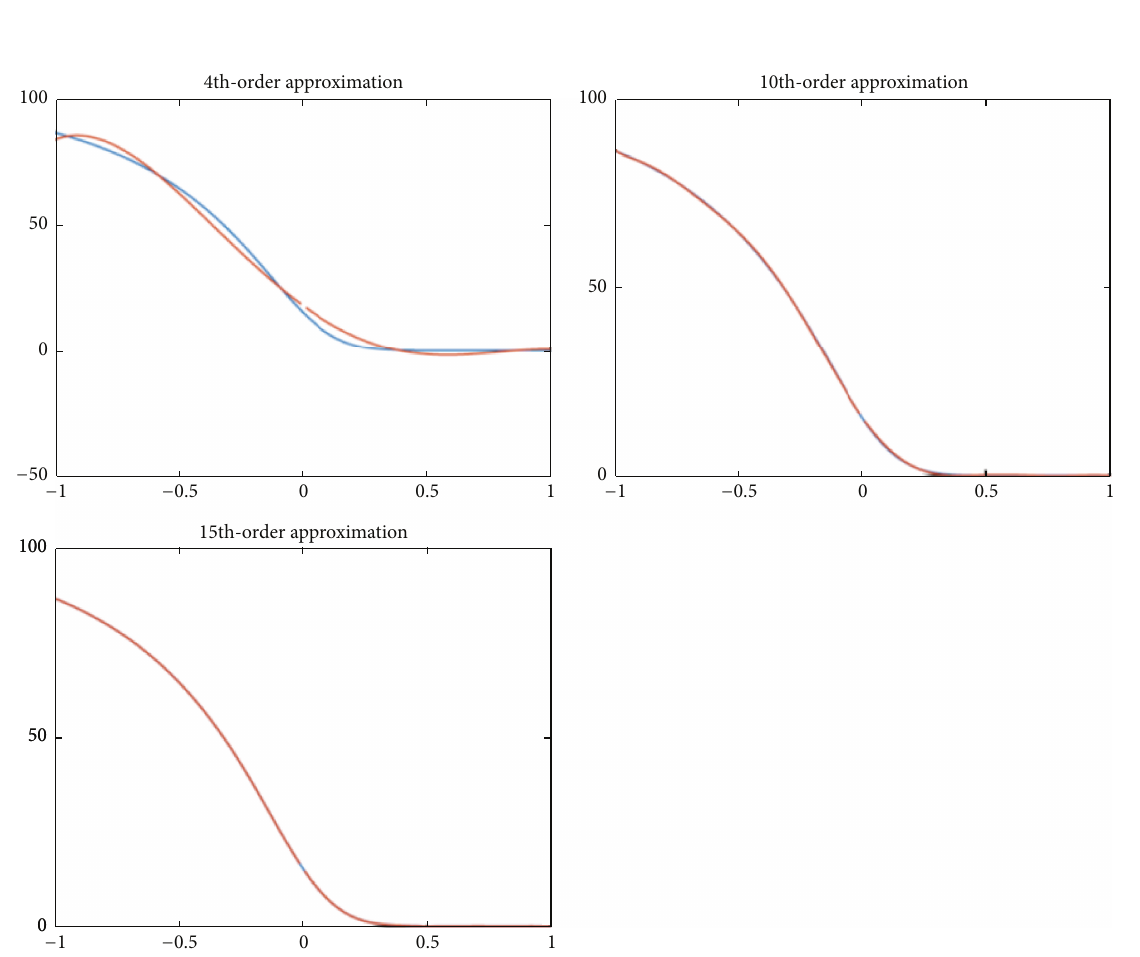
lesser computational time, but for large asset correlations it is not as accurate as the